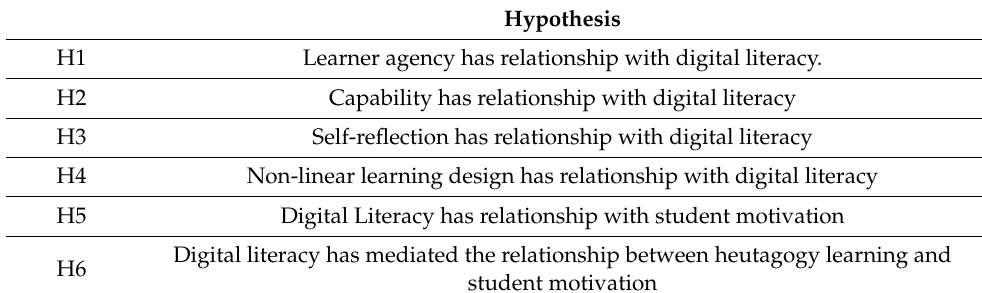
Table 1. Hypotheses.